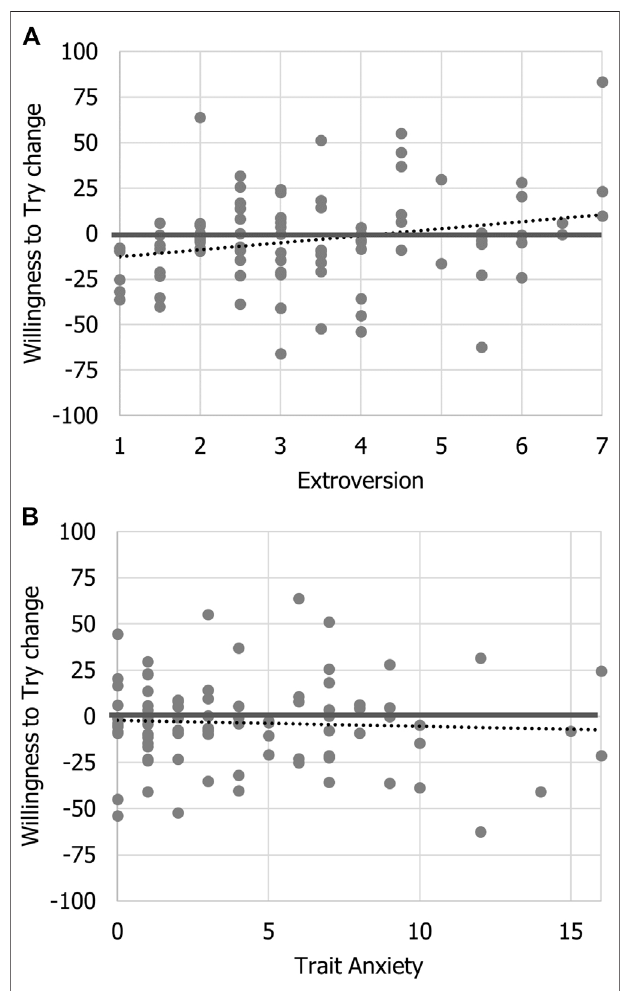
FIGURE8| Involvingperformancevisibleonamonitor. (A) :depictingthe relationship between the extroversion measure and how much more likely people were willing to try VR from Solo + NoAudience to Solo + Audience + Monitor. (B) : as before but for the trait anxiety measure. Trendlines have been added (based on the Pearson Correlation coef fi cient